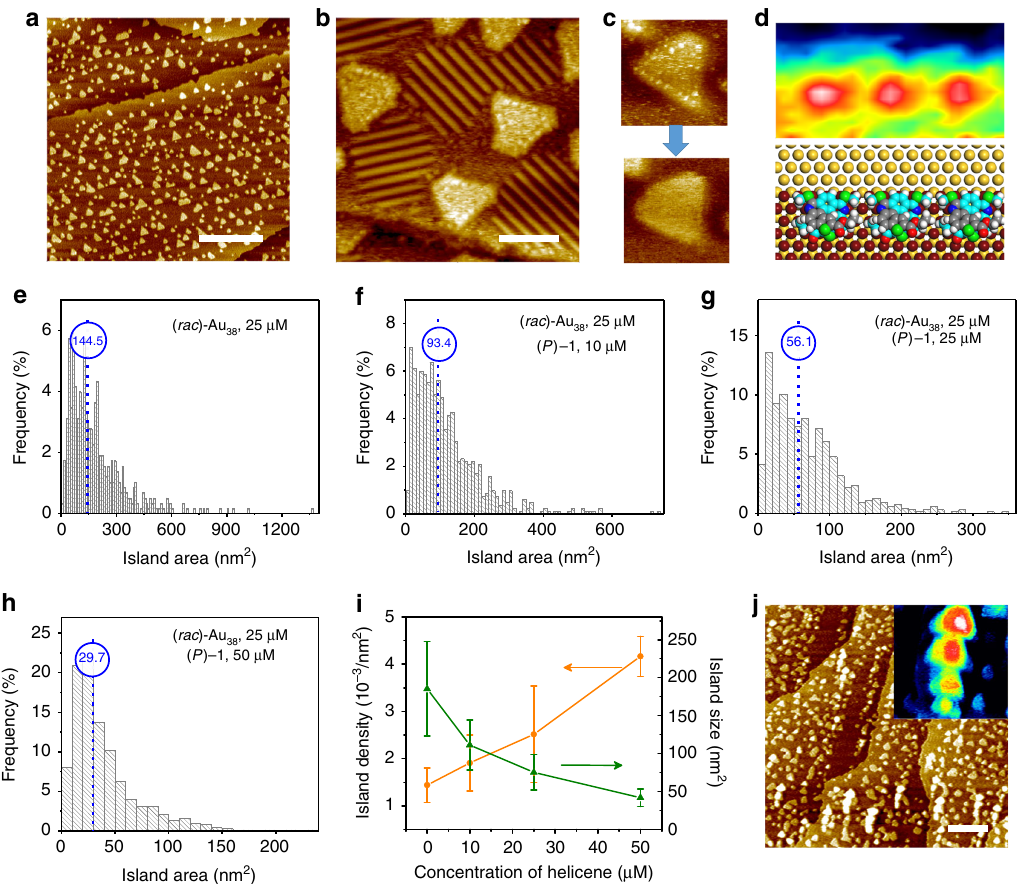
Fig. 4 Morphological control: the shape, the size and the layers. a , b STM images acquired on Au(111) surface after the deposition of a premixed TCB solution containing 25 µ M ( rac )-Au 38 and 25 µ M ( P )-1. a I set = 100 pA, V bias = – 1 mV; b I set = 100 pA, V bias = − 900mV. c STM images showing the islands before and after the removal, by the STM tip, of adsorbed species. d Contrast STM image (2.3 × 4.6 nm 2 ) and structural model of an array of ( P )-1 at the step of a triangular island. e – h Histograms of the size of gold islands at various ( P )-1 concentrations, from 0 µ M ( e ), 10 µ M ( f ), 25 µ M ( g ) to 50 µ M ( h ), while the concentration of ( rac )-Au 38 is kept constant at 25 µ M. The median sizes are indicated in blue. i Average island density and area versus the concentration of helicene in solution. The concentration of ( rac )-Au 38 is 25 µ M. The error bars were calculated as a s.d. of at least six images. j 3D mound formation in a mixture of 25 µ M ( P )-1 and 50 µ M ( rac )-Au 38 . I set = 140 pA, V bias = – 800 mV. The blue, yellow, red, and white colors in the inset outline four different layers. Scale bars: a , 100 nm; b , 10 nm; j , 50